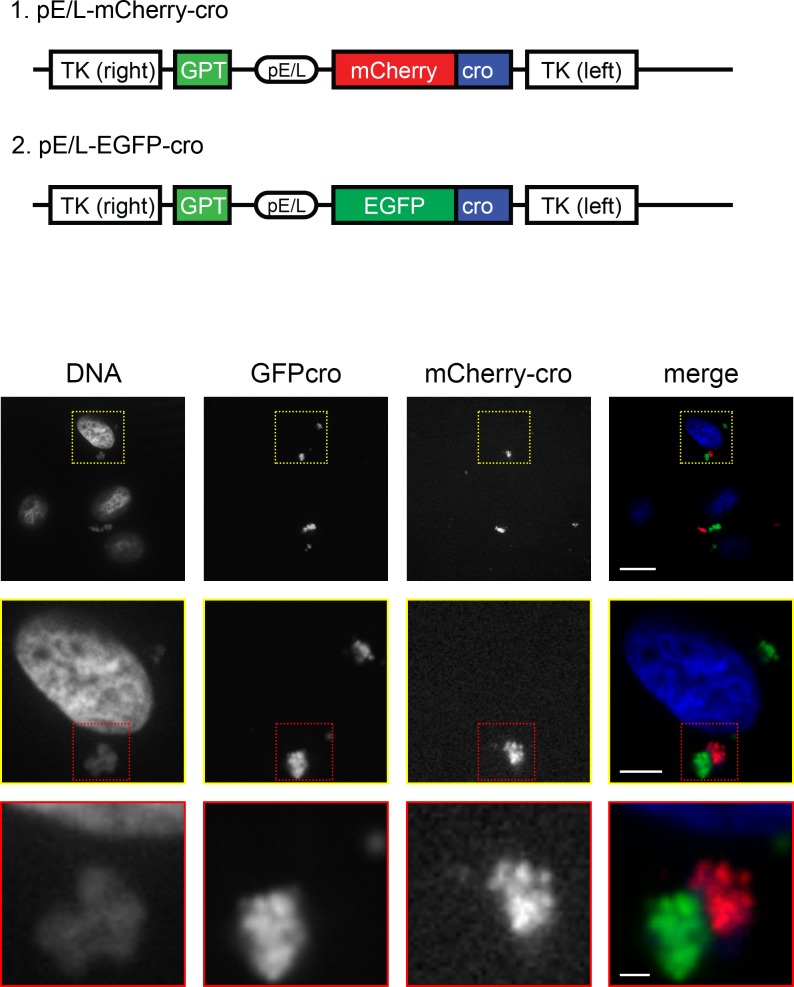
Maintenance of factory boundaries at an early stage of co-infection.BSC-40 cells were co-infected with pE/L-mCherry-cro and pE/L-EGFP-cro viruses (schematics, top) for 4 h and then fixed and stained with DAPI to also detect virus and cell DNA. The images shown here are taken from a single Z-stack showing closely associated factories, one labeled with EGFP-cro and the other mCherry-cro. The images were collected with a spinning disk microscope at 60× magnification. See S9 Video for an alternative view of the image. The scale bars are 15 μm (top), 5 μm (middle), and 1 μm (bottom panel).